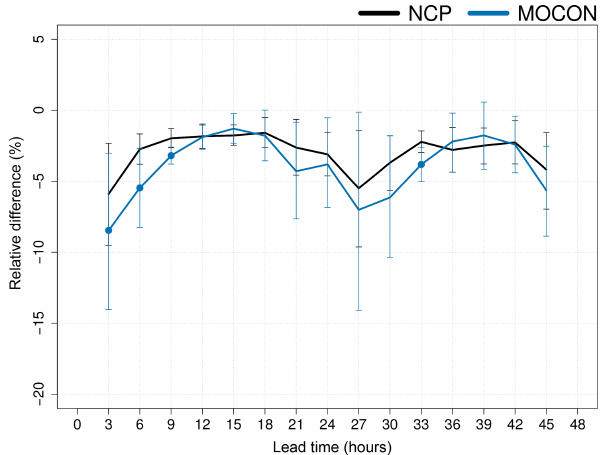
Figure 17. Relative change in precipitation CRPS with respect to the CP ensemble of 3-hourly averaged precipitation for the NCP (black) and MOCON (blue) ensemble. All ensembles include IC and LBC perturbations. The error bars show the 95% confidence in- terval. Lead times where the CRPS of MOCON is significantly dif- ferent from that of NCP are indicated with filled circles. The CRPS is calculated with respect to TRMM observations.